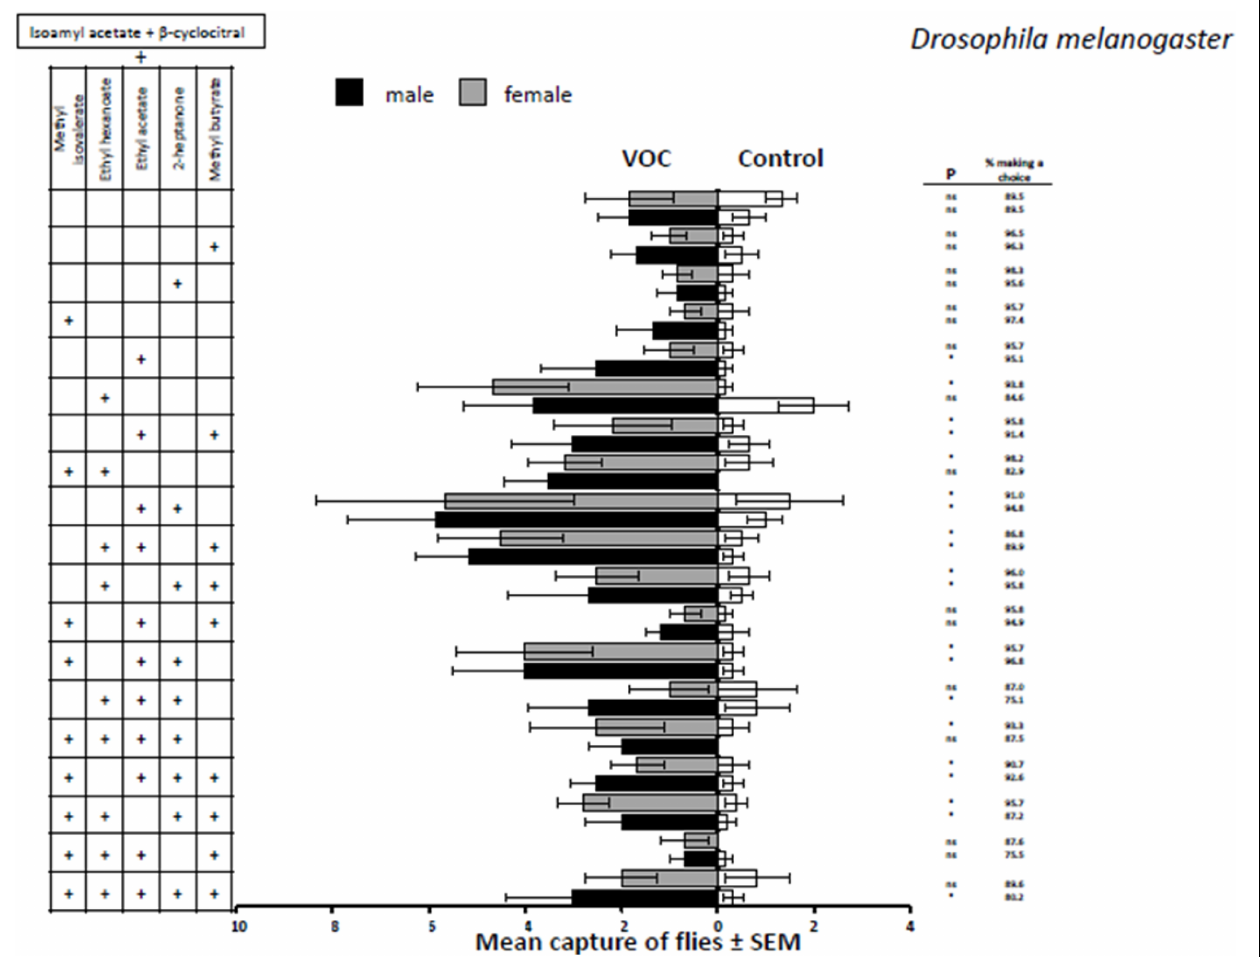
FIGURE 5 | Response of male and female D. melanogaster to selected mixtures of fruit volatiles added to isoamyl acetate and β -cyclocitral (VOC) against the mineral oil solvent (Control). P -values with ∗ indicate P <